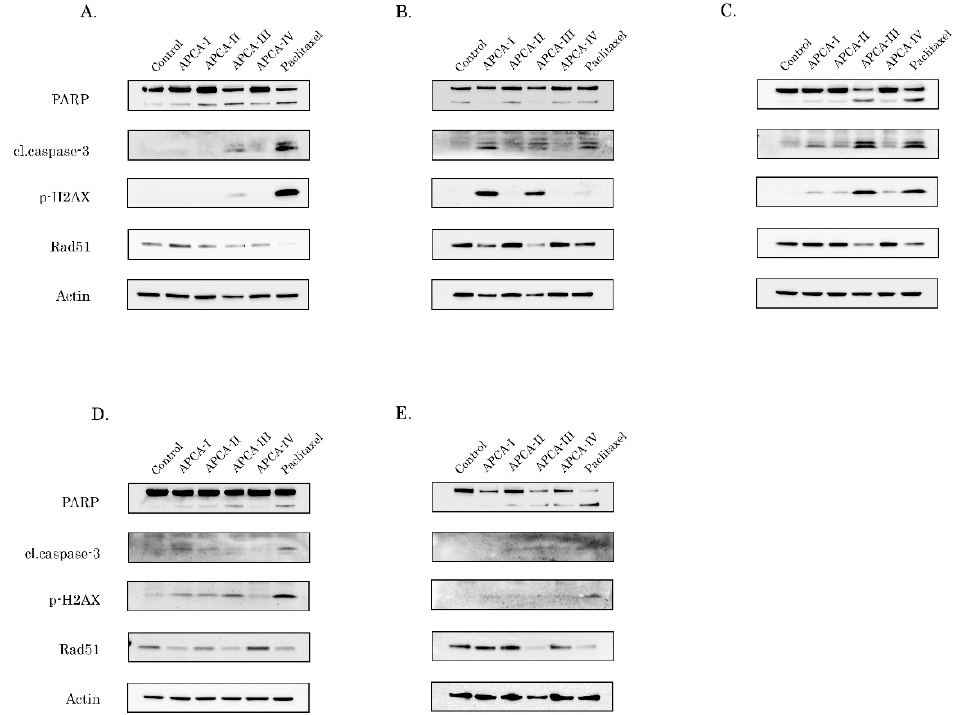
Figure 5. The 2-APCAs induce apoptosis of epithelial cancer cell lines. Immunoblot analysis for apoptosis markers (cleaved forms of PARP and caspase-3), Rad51 recombinase, and γ -H2AX in Н CC1806 ( A ), MDA-MB-231 ( B ), H1299 ( C ), PC-3 ( D ), and Не La ( E ) cells after treatment with DMSO (negative control), 2-APCAs (I-IV), and paclitaxel for 72 h. Actin stain used as a loading control.